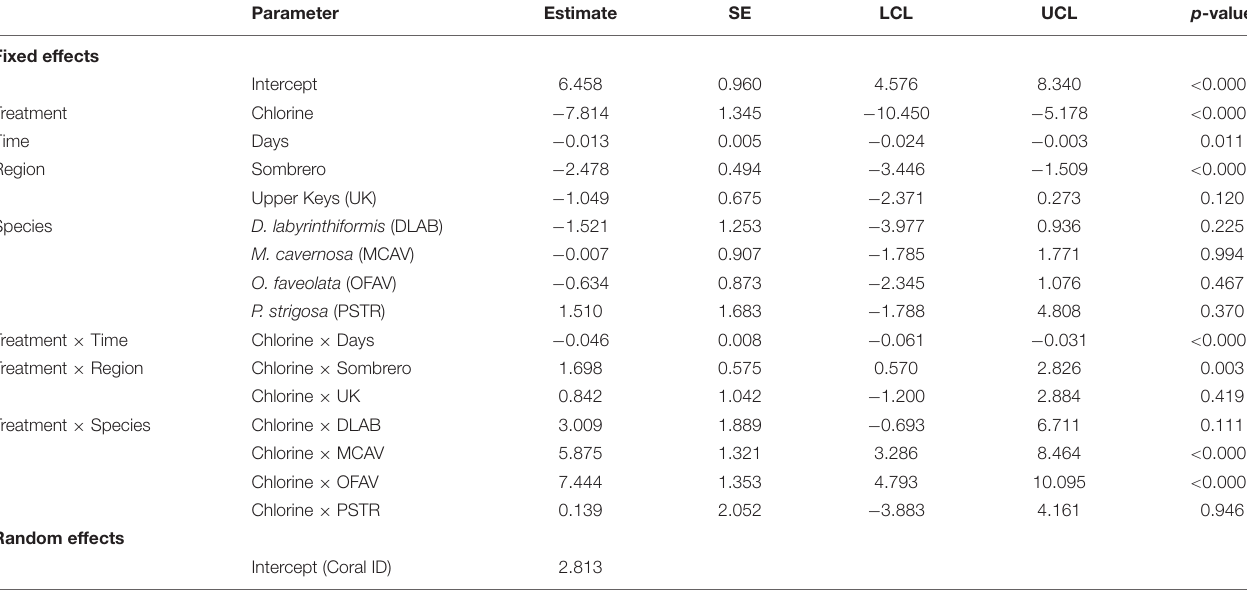
TABLE 2 | Parameter estimates affecting the probability of halted disease progression up to 3 months after